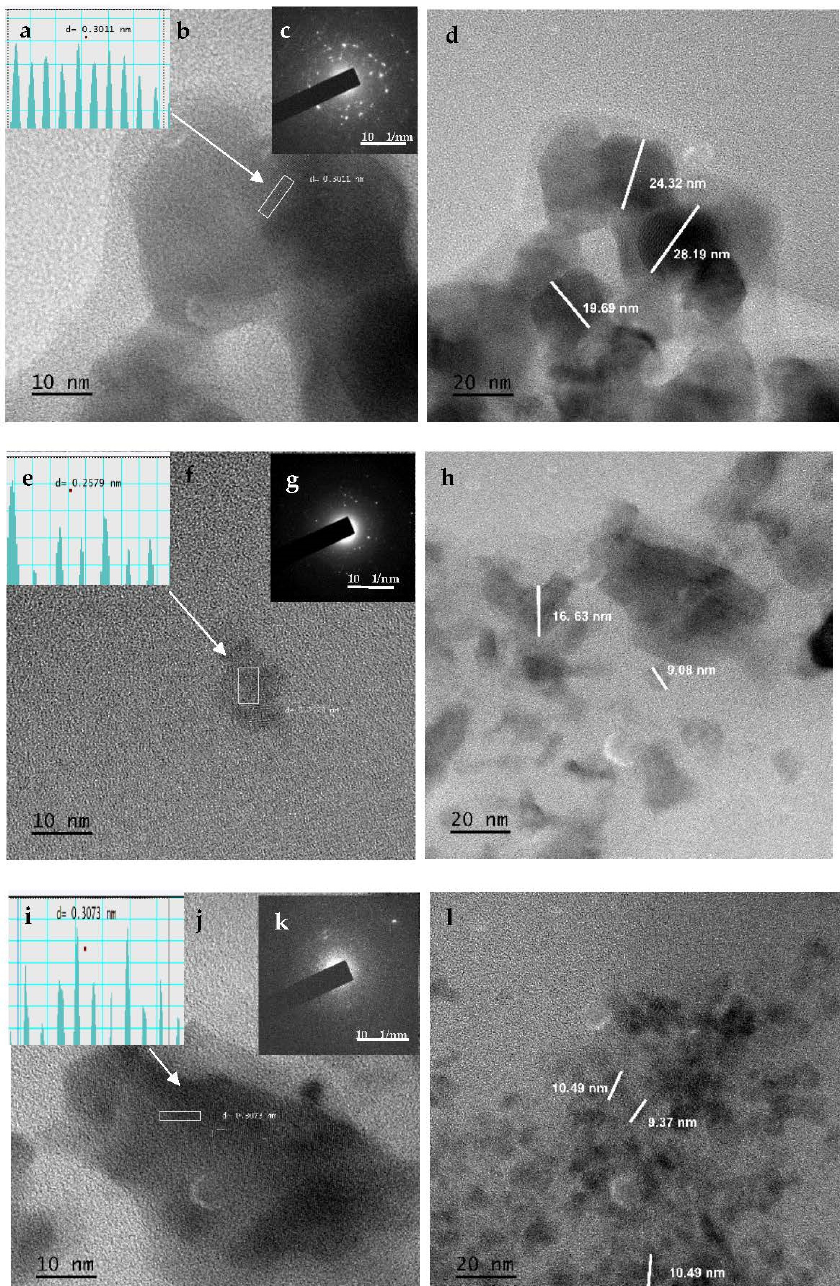
Figure 5. TEM images, d-spacing, and SEAD for NiSa ( a – d ), NiSb ( e – h ), and NiSc ( i – l ) nanoparticles. Table 1. Summary of NiSa, NiSb, and NiSc nanoparticles prepared by SSPs approach. Samples Particle Size (TEM Images